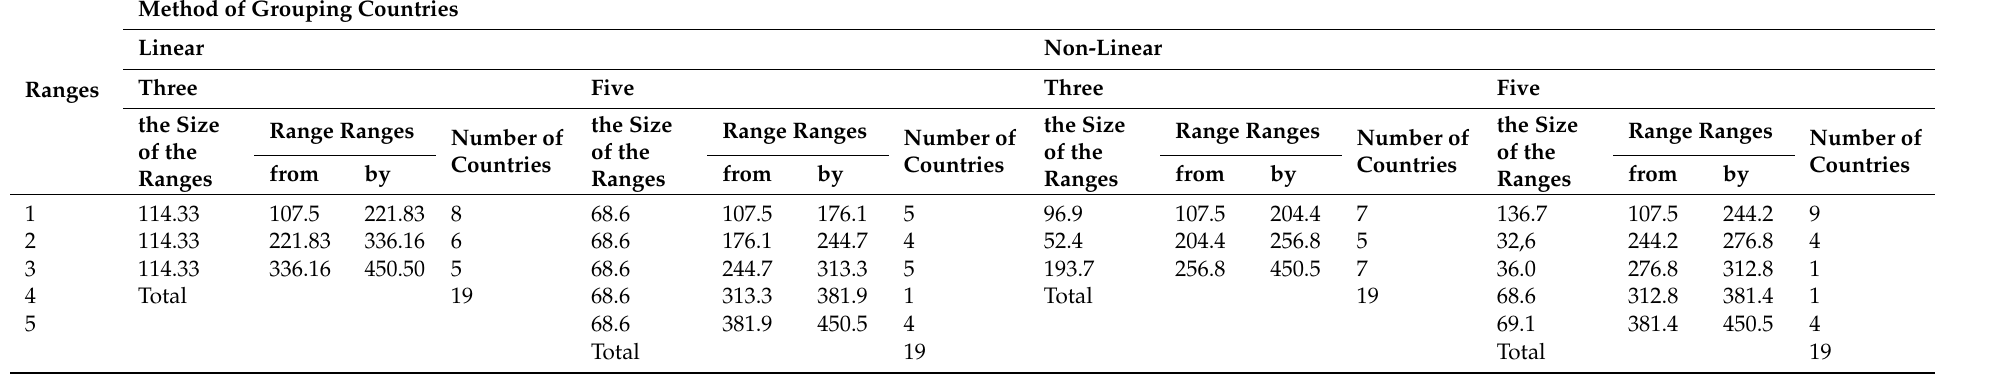
Table 3. Grouping of euro area countries in the European Union according to the cost-effectiveness of the energy development of the industrial sector (source: drawn up by the